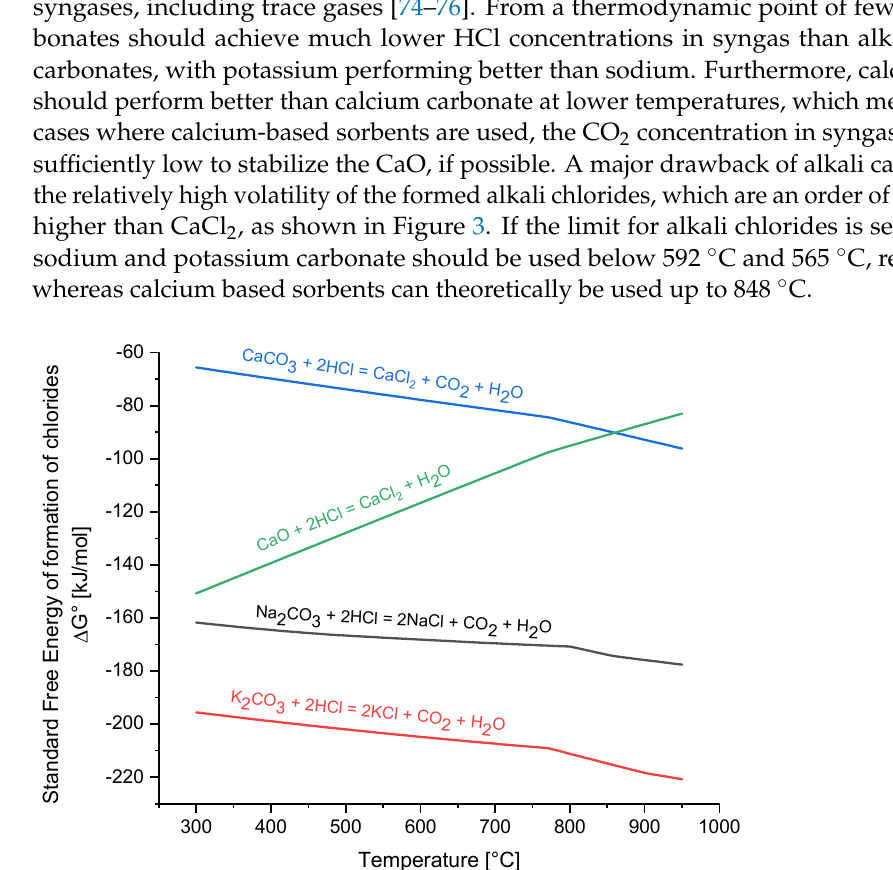
Figure 3. Vapor pressure of alkali and alkaline earth chlorides. The dashed line marks the concen- tration of 1 ppmv at 1 bar total pressure.